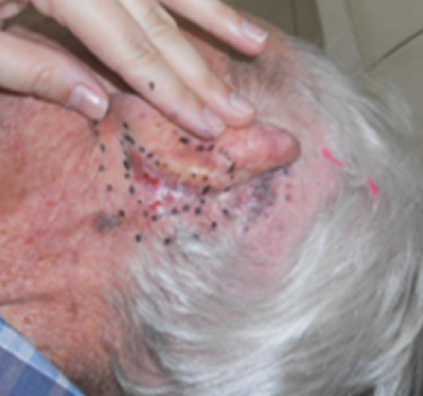
Figure 8: Electrons do prefer a flat field. Oftentimes the fields needed to be treated are modified in order to make them flat. For example, the ear can be taped forward in order to render flat the lesion that spreads from medial surface of the pinna to the lateral skin of the scalp. Figure 9: The depth of skin is on the X axis, the amount of radio-